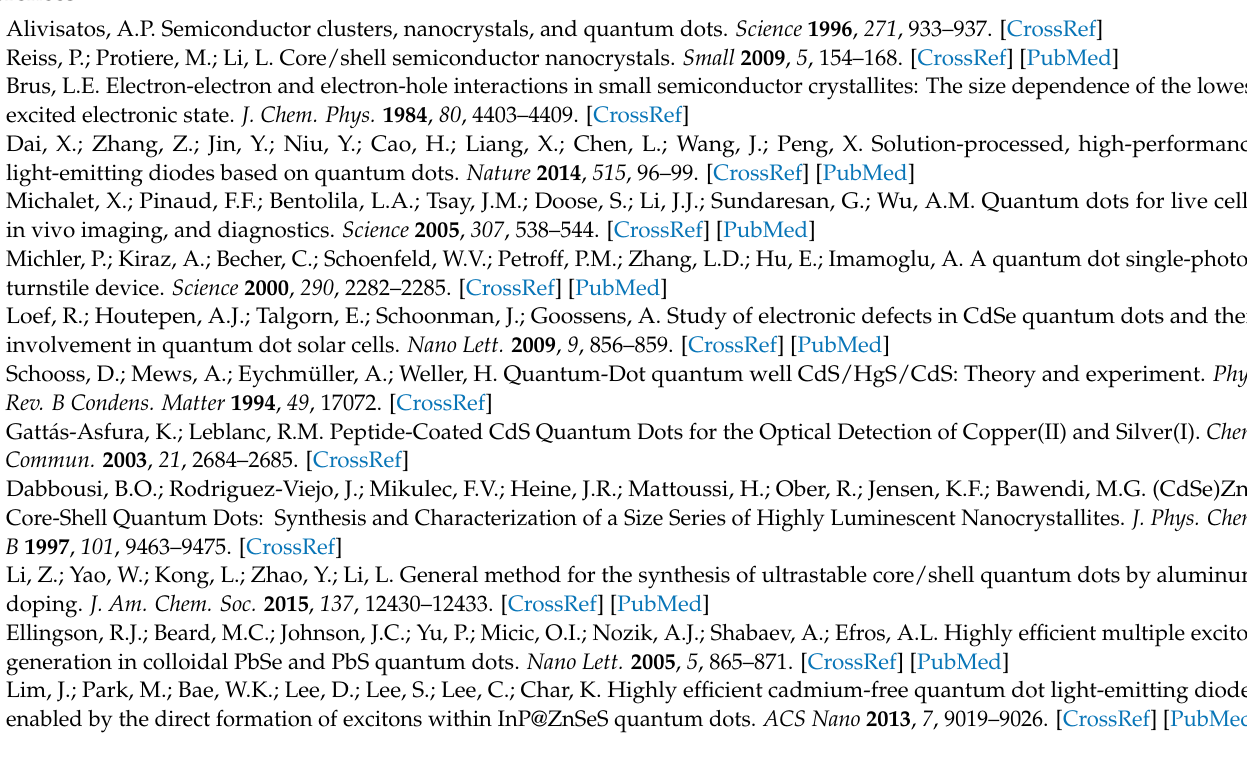
Figure S7: The reduction of Cr (VI) with InP/ZnSe/ZnS:Zr QDs treated under simulated sunlight irradiation; Table S1: The position of PL peak and FWHM of InP/ZnSe/ZnS and InP/ZnSe/ZnS:Zr (with different Zr concentrations) QDs; Table S2: The EDX results of InP/ZnSe/ZnS:Zr QDs with the theoretical S: Zr molar ratios equaling